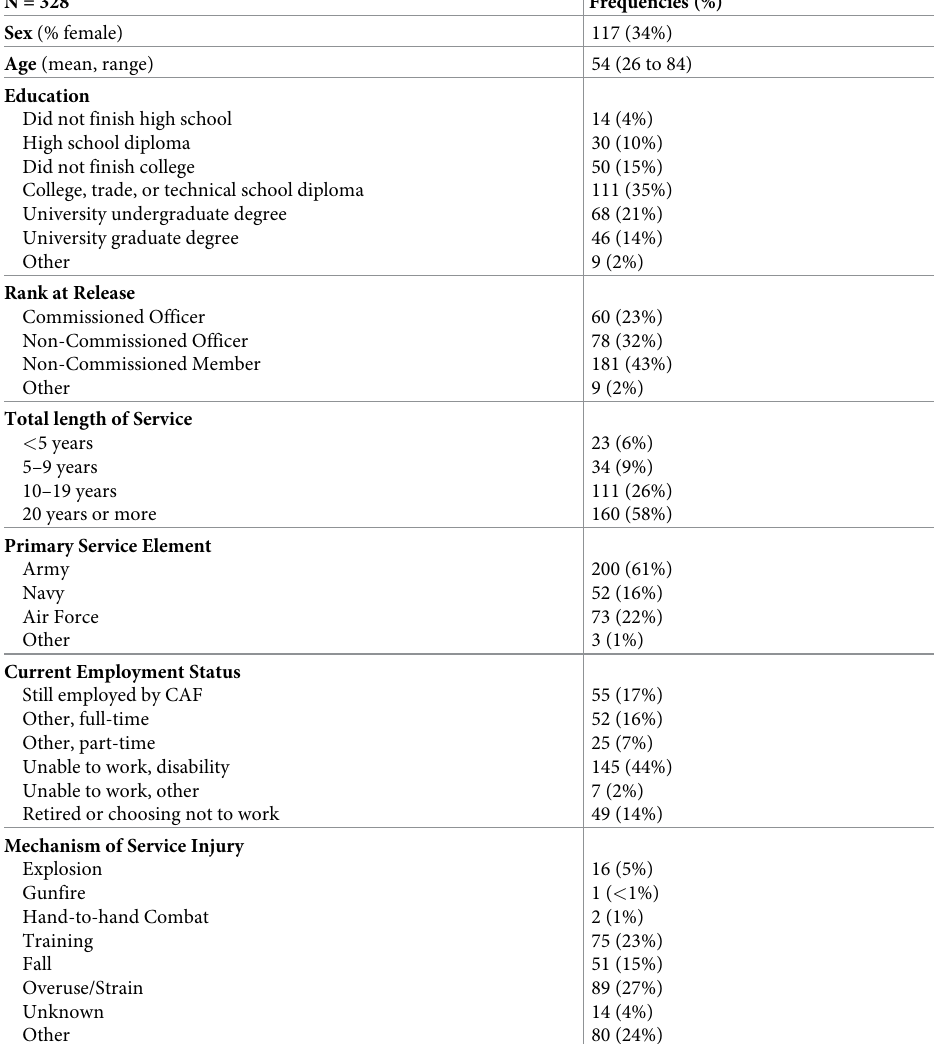
Table 1. Characteristics of participants in the entire